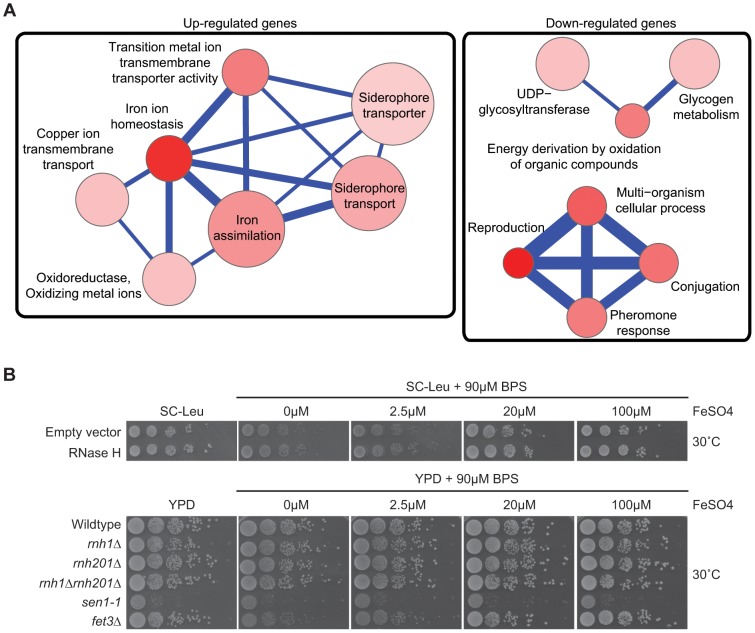
Pathways altered at the transcript level by RNase H overexpression.(A) Gene Ontology term network of genes with increased (left) or decreased (right) mRNA levels upon RNase H overexpression. Representative terms from Supplementary Table S10 are shown. Node size indicates fold enrichment. Node color indicates the number of genes associated with each term (the darkest indicating the greatest number of genes associated). Edge thickness indicates the number of genes shared between terms. (B) 10-fold serial dilutions on BPS iron plates testing low iron concentration sensitivity of wild type versus DNA:RNA hybrid forming mutants reveals a lack of cellular iron requirement in RNase H mutant strains.